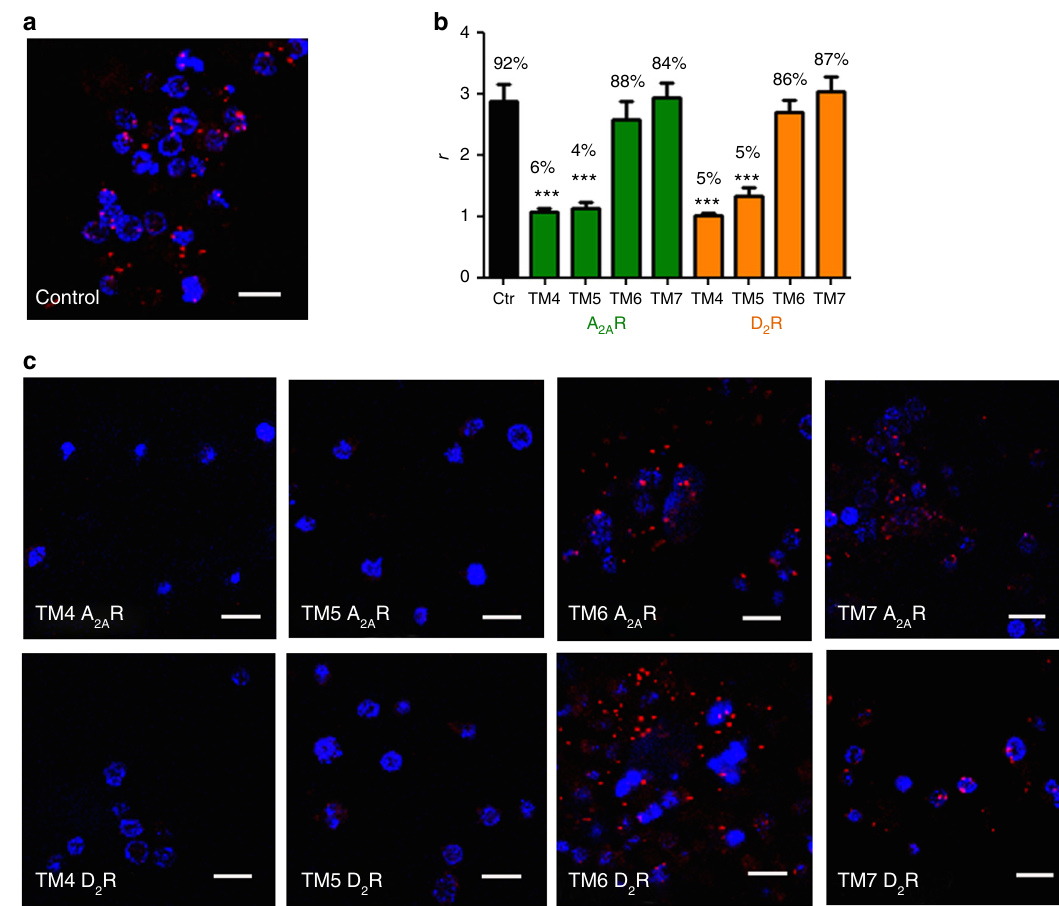
Fig. 5 A 2A R-D 2 R heterotetramer expression in striatal neurons in culture. Proximity ligation assay (PLA) in rat striatal primary cultures. a , c Confocal microscopy images (superimposed sections) are shown in which A 2A R-D 2 R heteromers appear as red spots. Primary cultures were treated for 4 h with medium ( a ) or 4 μ M of indicated TM peptides (numbered 1 – 7) of A 2A R or D 2 R ( c ); cell nuclei were stained with DAPI (blue); scale bars: 20 μ m. b Quanti fi cation from PLA experiments: values (in means ± SEM) are expressed as the ratio between the number of red spots and the number of cells showing spots ( r ) (20 – 30 neurons from three independent preparations); % values represent the percentage of cells showing one or more red spots; *** p < 0.001, as compared to control (one-way ANOVA followed by Dunnett ’ s multiple comparison